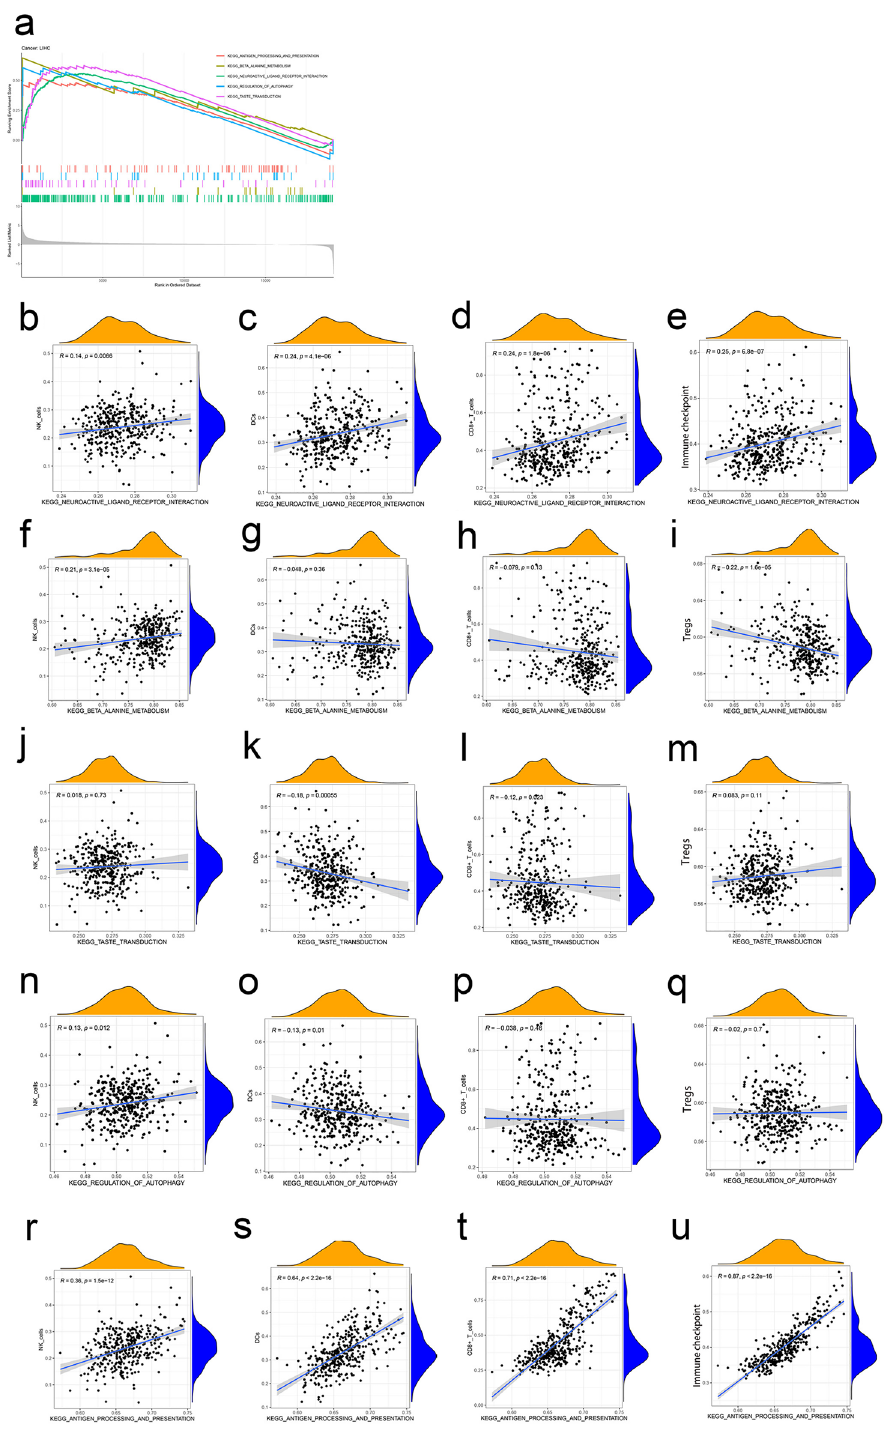
Figure 6. GSEA in the TCGA-LIHC dataset. ( a ) GSEA in LIHC. ( b-e ) Correlation between the “KEGG neuroactive ligand receptor interaction" pathway and NK cells, DCs, CD8 + T cells and immune checkpoint. ( f – i ) Correlation between the "KEGG βalanine metabolism" pathway and NK cells, DCs, CD8 + T cells and Tregs. ( j – m ) Correlation between the “KEGG taste transduction” pathway and NK cells, DCs, CD8 + T cells and Tregs. ( n – q ) Correlation between the “KEGG regulation of autophagy" pathway and NK cells, DCs, CD8 + T cells and Tregs. ( r – u ) Correlation between the "KEGG antigen processing and presentation" pathway and NK cells, DCs, CD8 + T cells and immune